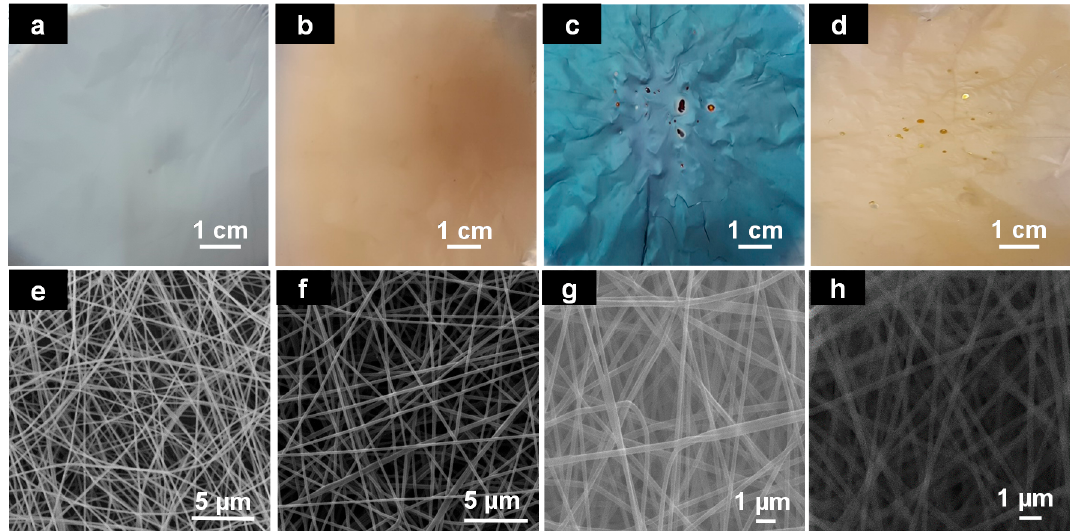
Figure 1. Photographs of electrospun fibers (PVN) ( a ) and deposited samples with TiO 2 at different temperatures: ( b ) PVN_150, ( c ) PVN_200; ( d ) PVN_150/250; and SEM images of: ( e ) PVN, ( f ) PVN_150, ( g ) PVN_200, ( h ) PVN_150/250.